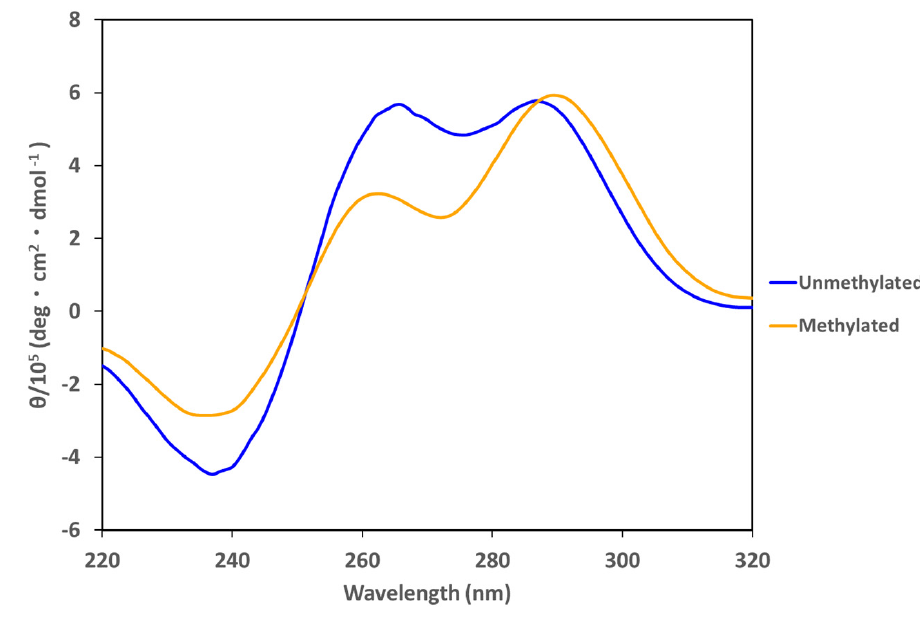
Figure 4. CD spectrum of HRAS2 G4/i-motif-mixed DNAs at pH 5.8 of unmethylated (blue) and methylated (orange) DNAs.